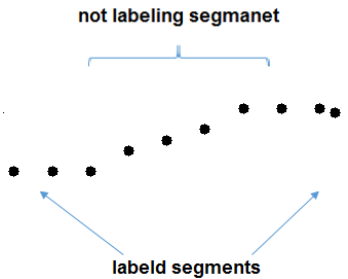
Figure 6. not labelled segment between 2 labelled segments with different